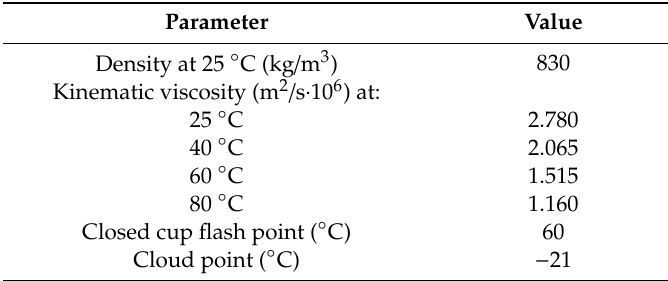
Table 1. Diesel fuel properties.